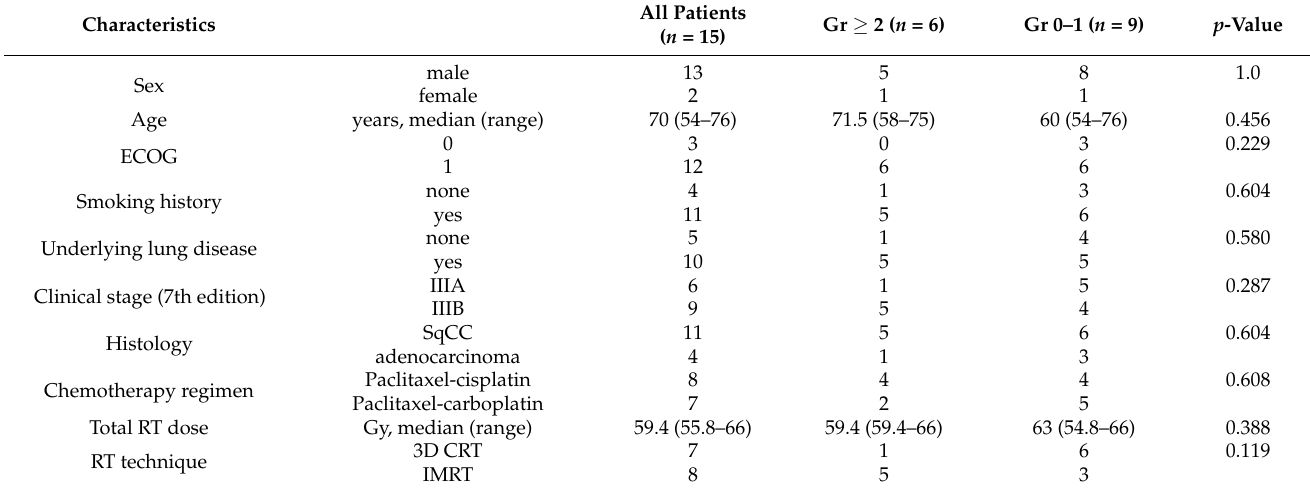
Table 1. Clinical characteristics of patients with Grade ≥ 2 and Grade 0–1 radiation pneumonitis.